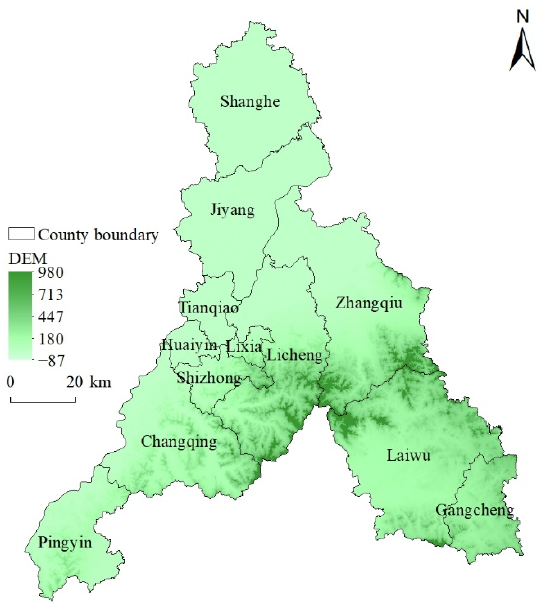
Figure 2. Map of study